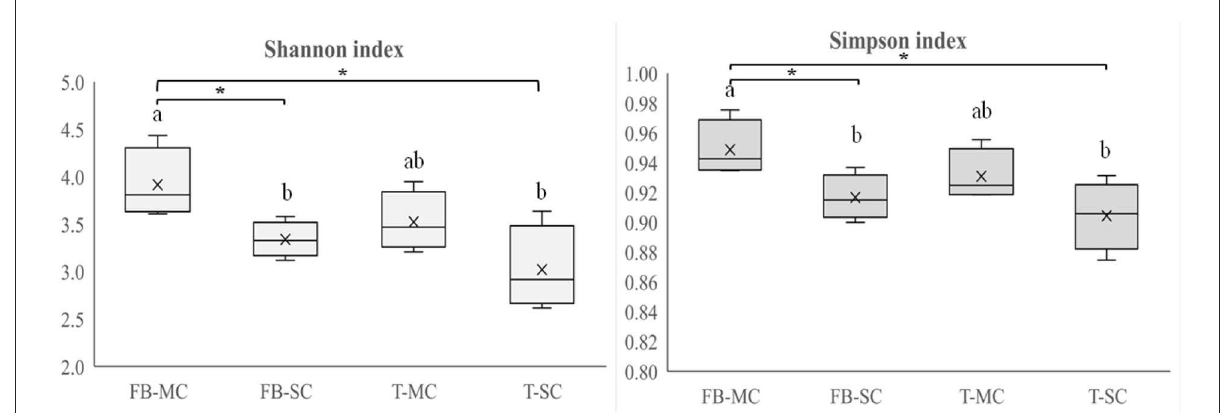
FIGURE5 Fungal community diversity indices (Shannon index, Simpson index) recorded in faba bean (FB) and tomato (T) monocropping (MC) and strip cropping (SC) at CREA site. Levels of statistical significance ( p value) are: * p < 0.05, ** p < 0.01, and *** p < 0.001, ns, not significant (ANOVA). Different letters represent significant differences (Tukey’s HSD test for means